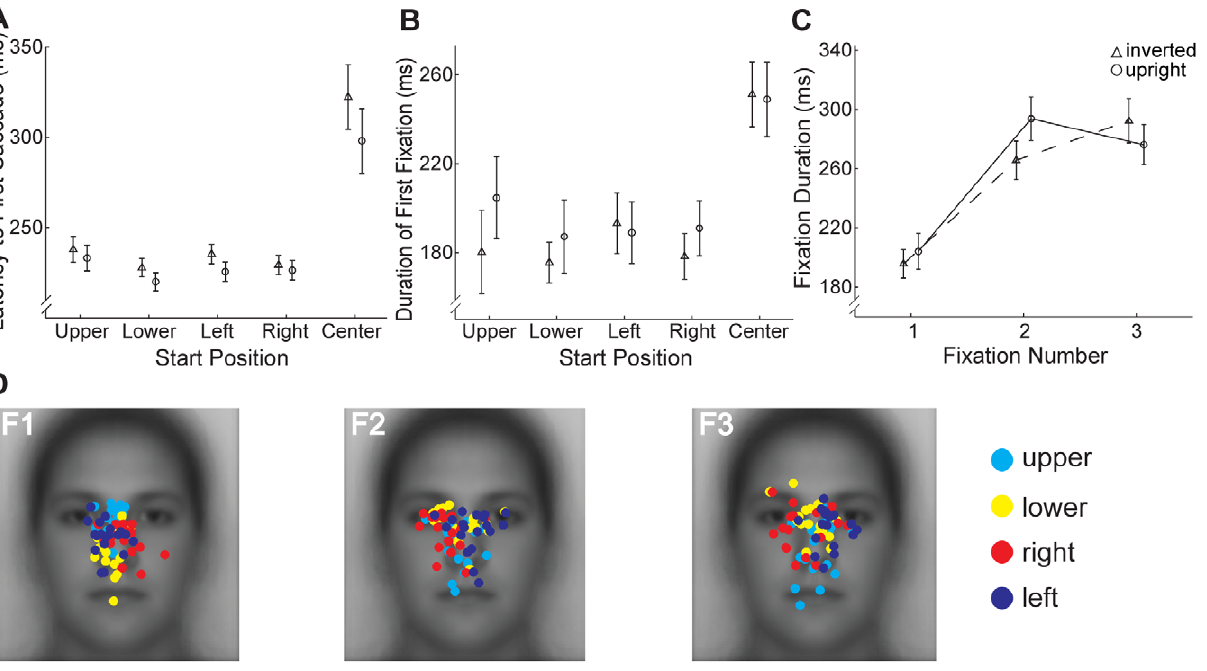
Figure 13. Analysis of fixations during the test phase. ( a ) Latency to first saccade by start position for upright and inverted faces. As for the study phase, there was a longer latency for the center start position compared with the peripheral start positions. ( b ) Duration of first fixation by start position for upright and inverted faces. Note the longer duration for the center start position, as observed during the study phase. ( c ) Duration of the first three fixations for the peripheral start locations for both upright and inverted faces. As for the study phase, the first fixation was significantly shorter than the subsequent fixations. All error bars indicate the between-subjects error. ( d ) Distribution of individual participants’ fixation locations for upright faces broken down by start position for each fixation number (F1–F3). The same pattern was observed as during the study phase with first fixation close to the center of the face and subsequent fixations landing on the opposite side of the face to the start position.